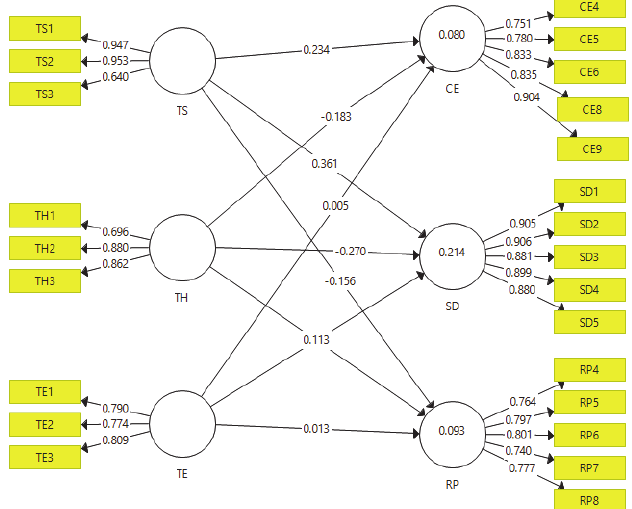
Fig. 2. Results for the hypothesized model with structural